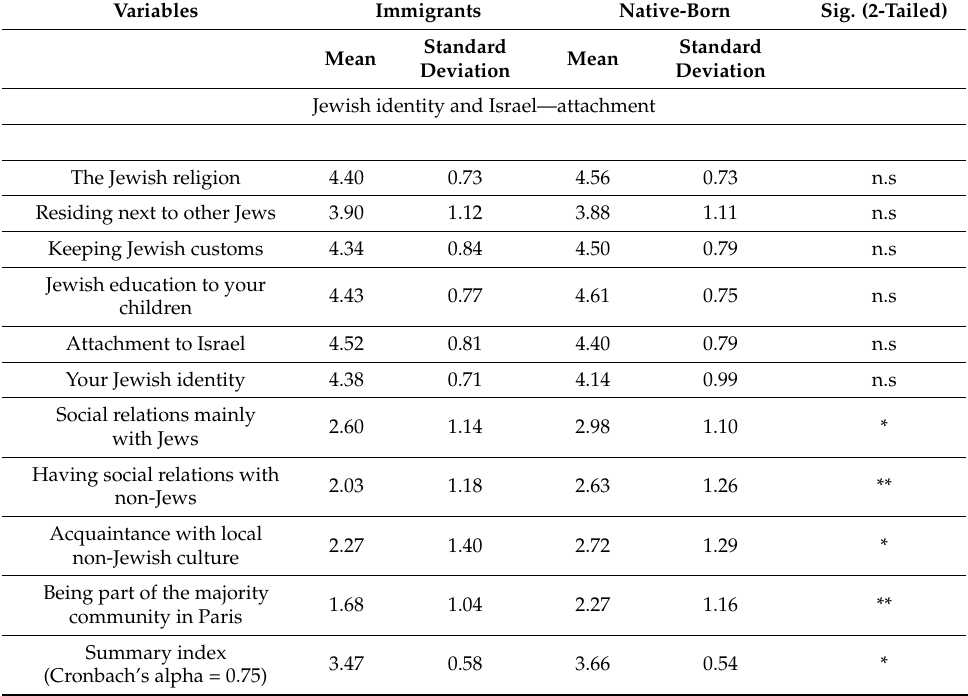
Table 2. Degree of importance attached to Jewish identity, social connections and integration: Im- migrants and native-born compared ( t -test analysis for independent samples, means and standard deviation, 1 = not at all, 5 = to a very large